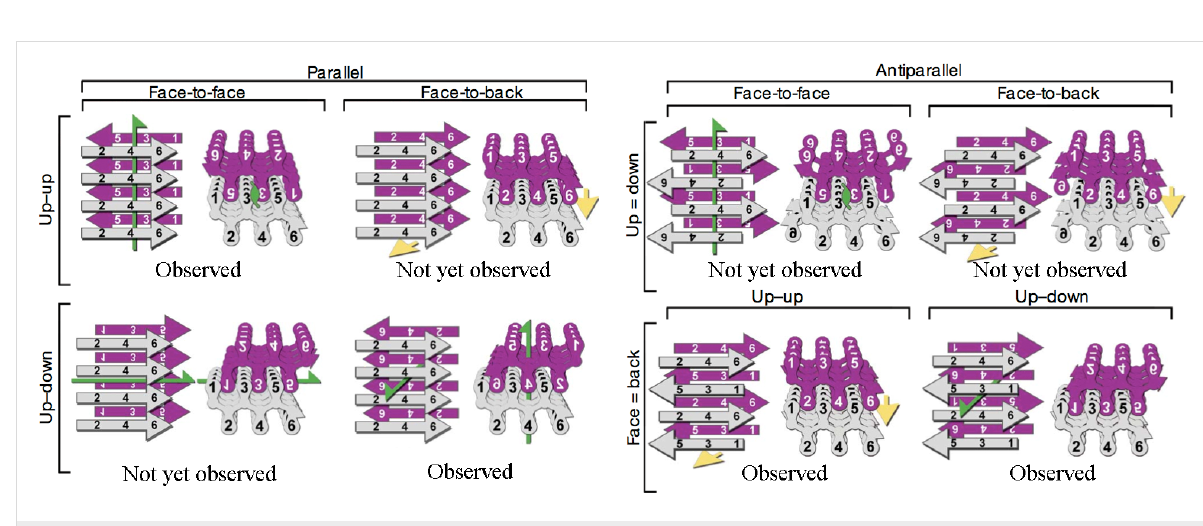
The double-layer arrangements were then created from the single layer arrangements. In principle, possible hypothetical double tape arrangements of the peptide core are depicted schematically in Figure